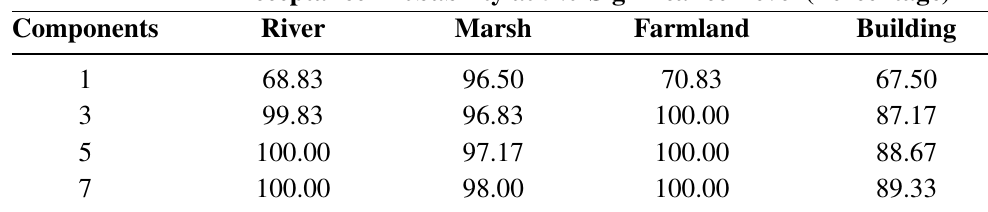
Table 5. Acceptance probability of mixture models with different number of